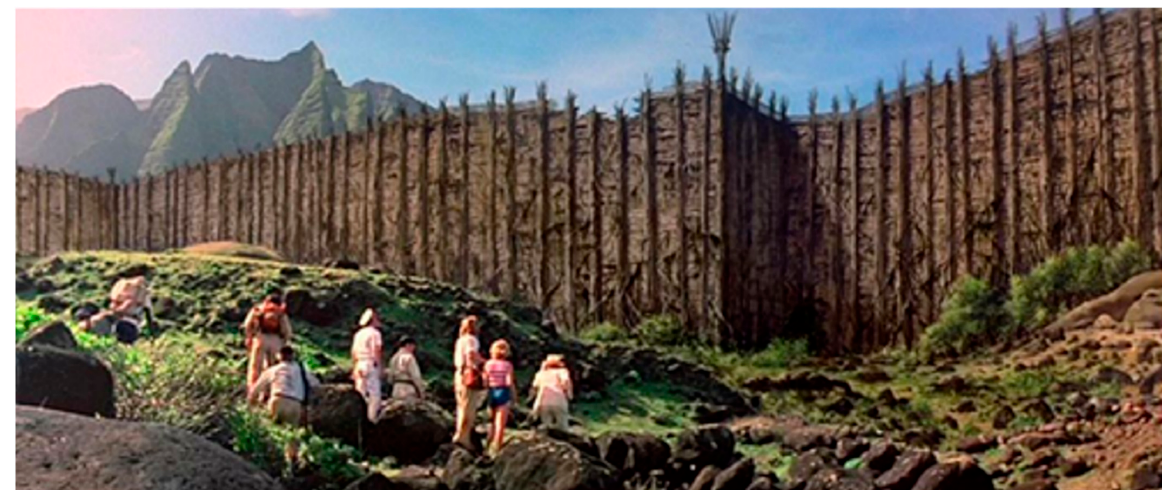
Figure 4. The outer walls of Skull Island: the ocean, the wall, and the mountains (1933). https://lh3.googleusercon- tent.com/proxy/3yTNlC8SJYRy_IGNeNFxvhcZXzABt1NCus3CG9-yISns- jidzxA4hAFQRCA4G2rrXGwhjINNfbWxZ_4juVvM-ibuyaFpuIDSkTcTcTBOK0zuFpuxSkTcTBOK0 (accessed on 1 Janu- ary 2021).